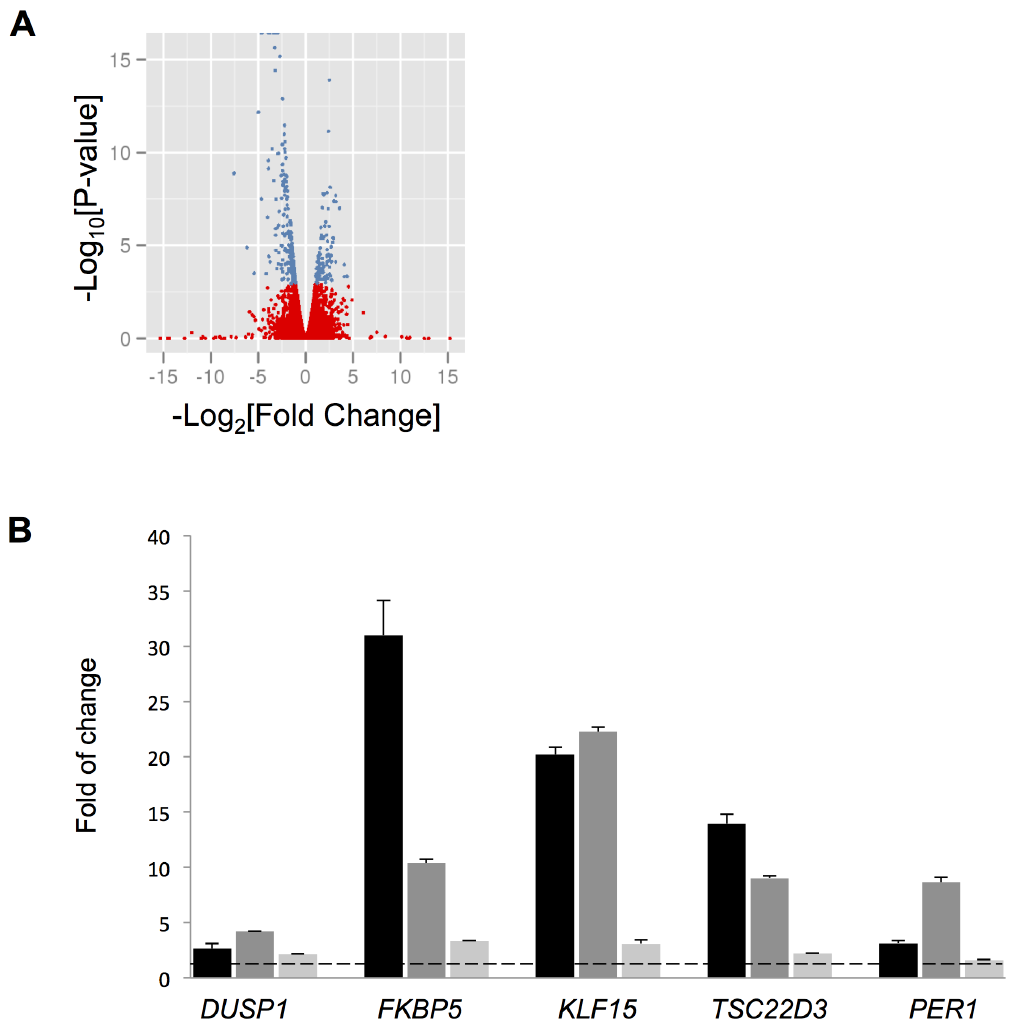
Figure 1. RNA-Seq profiling of DEX-treated ASM cells. A ) Volcano plot of overall gene-based differential expression results for four cell lines treated with DEX vs. left untreated (each dot corresponds to a gene). The y-axis corresponds to the negative log (base 10) of P-values while the x-axis corresponds to the negative log (base 2) of the fold change for difference in expression when cells were stimulated with DEX. There were 316 differentially expressed genes according to an adjusted p-value , 0.05 (blue dots). B ) Validation of known GC-responsive genes through qRT-PCR. After ASM cells were treated with 1 m M DEX for 18 h, the mRNA levels of indicated genes were measured by qRT-PCR and the folds of change in mRNA induced by DEX were calculated. Each column bar represents an individual cell line. Experiments for each cell line were performed in triplicate, and the error bars are SE values corresponding to a cell line’s replicates. The dotted line indicates a fold change of 1. ** P , 0.005, * P , 0.05 (t test).